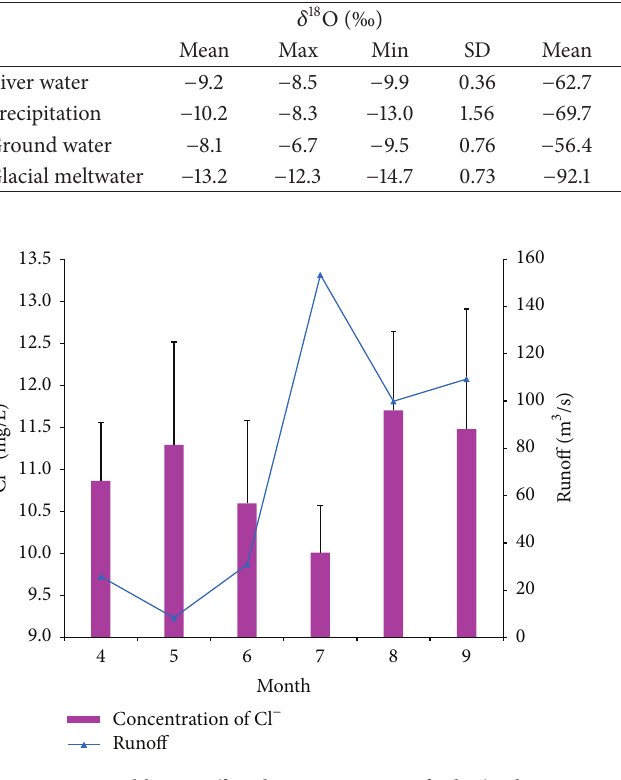
Figure 6: Monthly runoff and concentration of Cl − (with error bars).